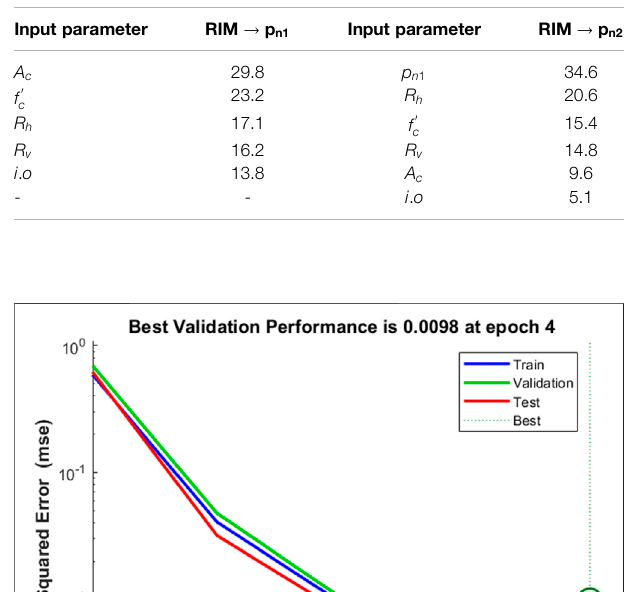
FIGURE 13 | Proposed ANN networks: (A) for the fi rst peak load ( P n1 ); (B) the fi rst peak load ( P n2 ).